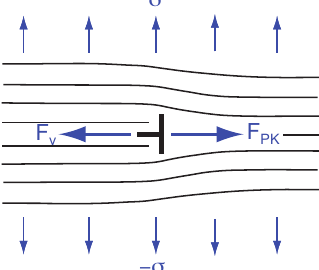
Figure 3. Peach and Koehler force and viscous force acting on an edge dislocation when the layers are dilated ( σ >